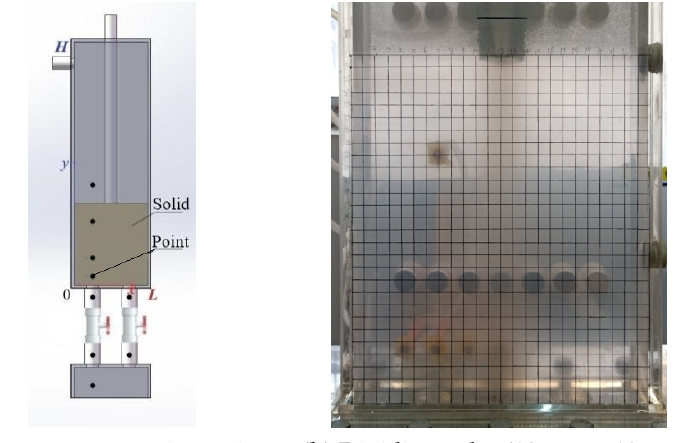
Figure 3. Schematic diagram of measuring positions (nine measuring points ( x/L = 0.25, y/H = − 0.5, − 0.25, − 0.025, 0.025, 0.08, 0.25 and 0.5; x/L = 0.75, y/H = − 0.025 and 0.025)).